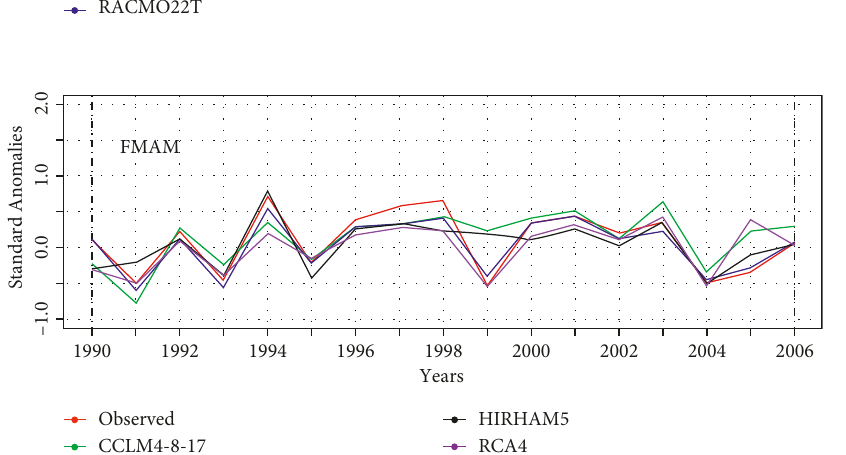
Table 11. In comparison, RACMO22T and RCA4 correlated better than others, at 0.52 and 0.43, respectively, in simu-